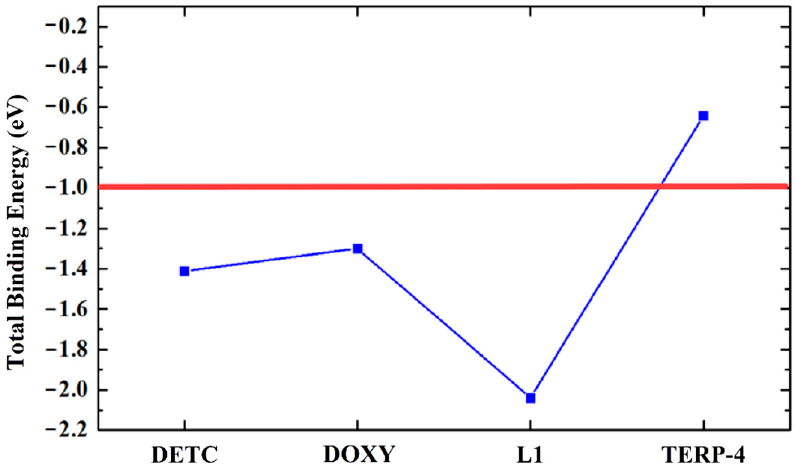
Figure 3. Graphical representation of the total binding energy (eV) of all ligands anchored with the gp63 protein.